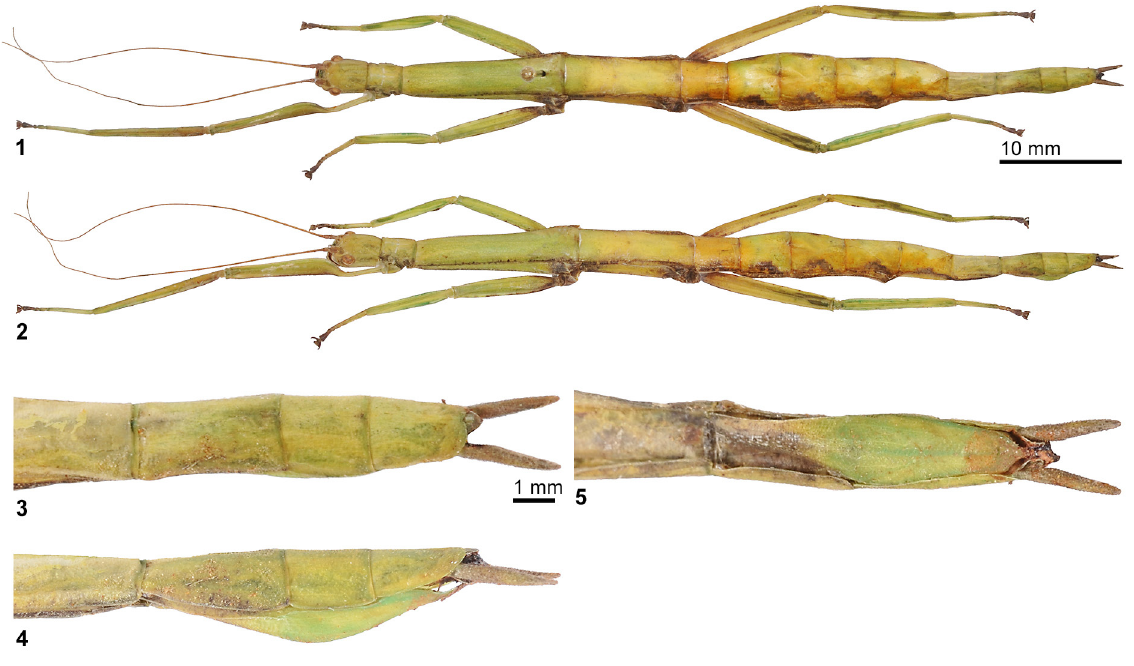
Figs 1–5. Phantasca adiposa sp. nov. Holotype, ♀. 1 . Habitus, dorsal view. 2 . Habitus, dorsolateral view. 3 . Apex of abdomen, dorsal view. 4 . Apex of abdomen, lateral view. 5 . Apex of abdomen, ventral